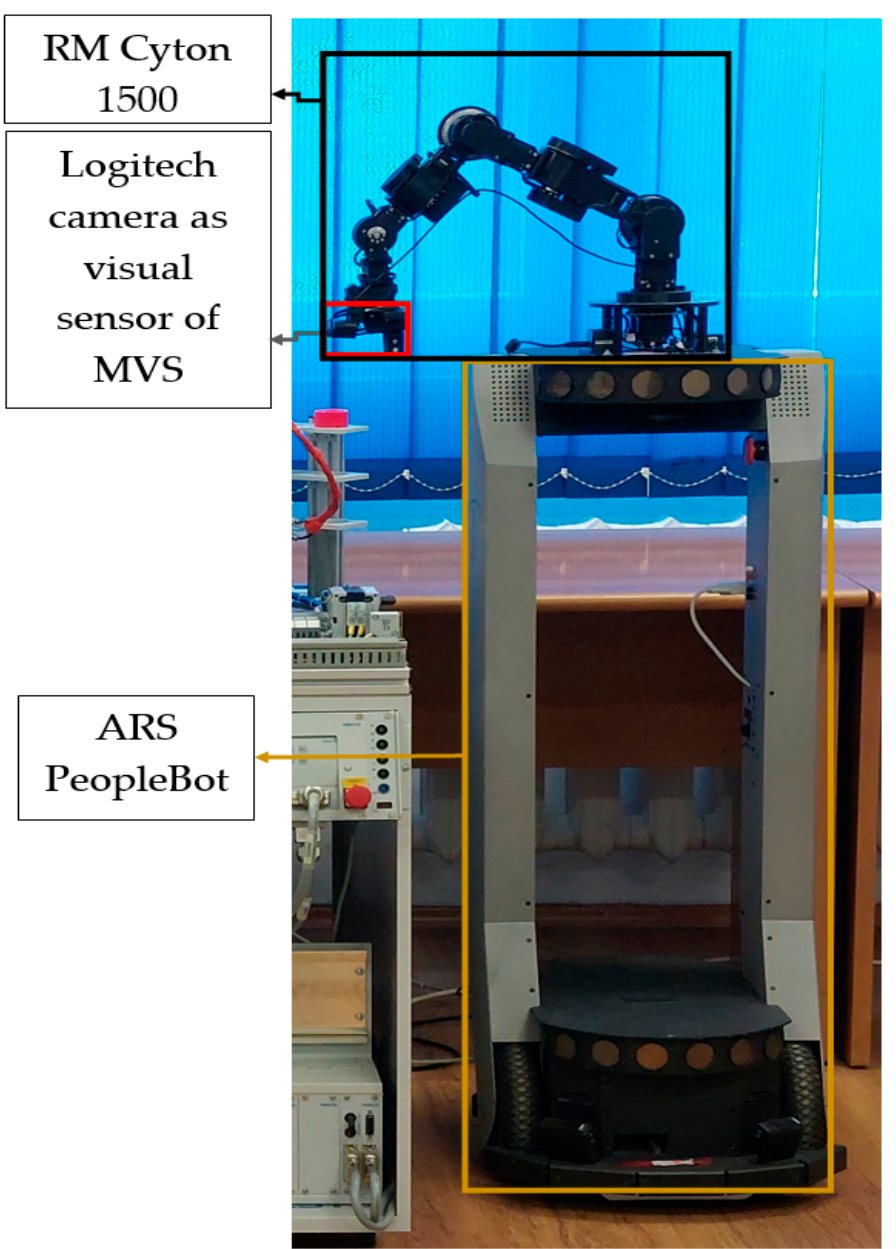
Figure 2. Structure of the CAS: ARS PeopleBot; RM Cyton 1500; eye in hand MVS.